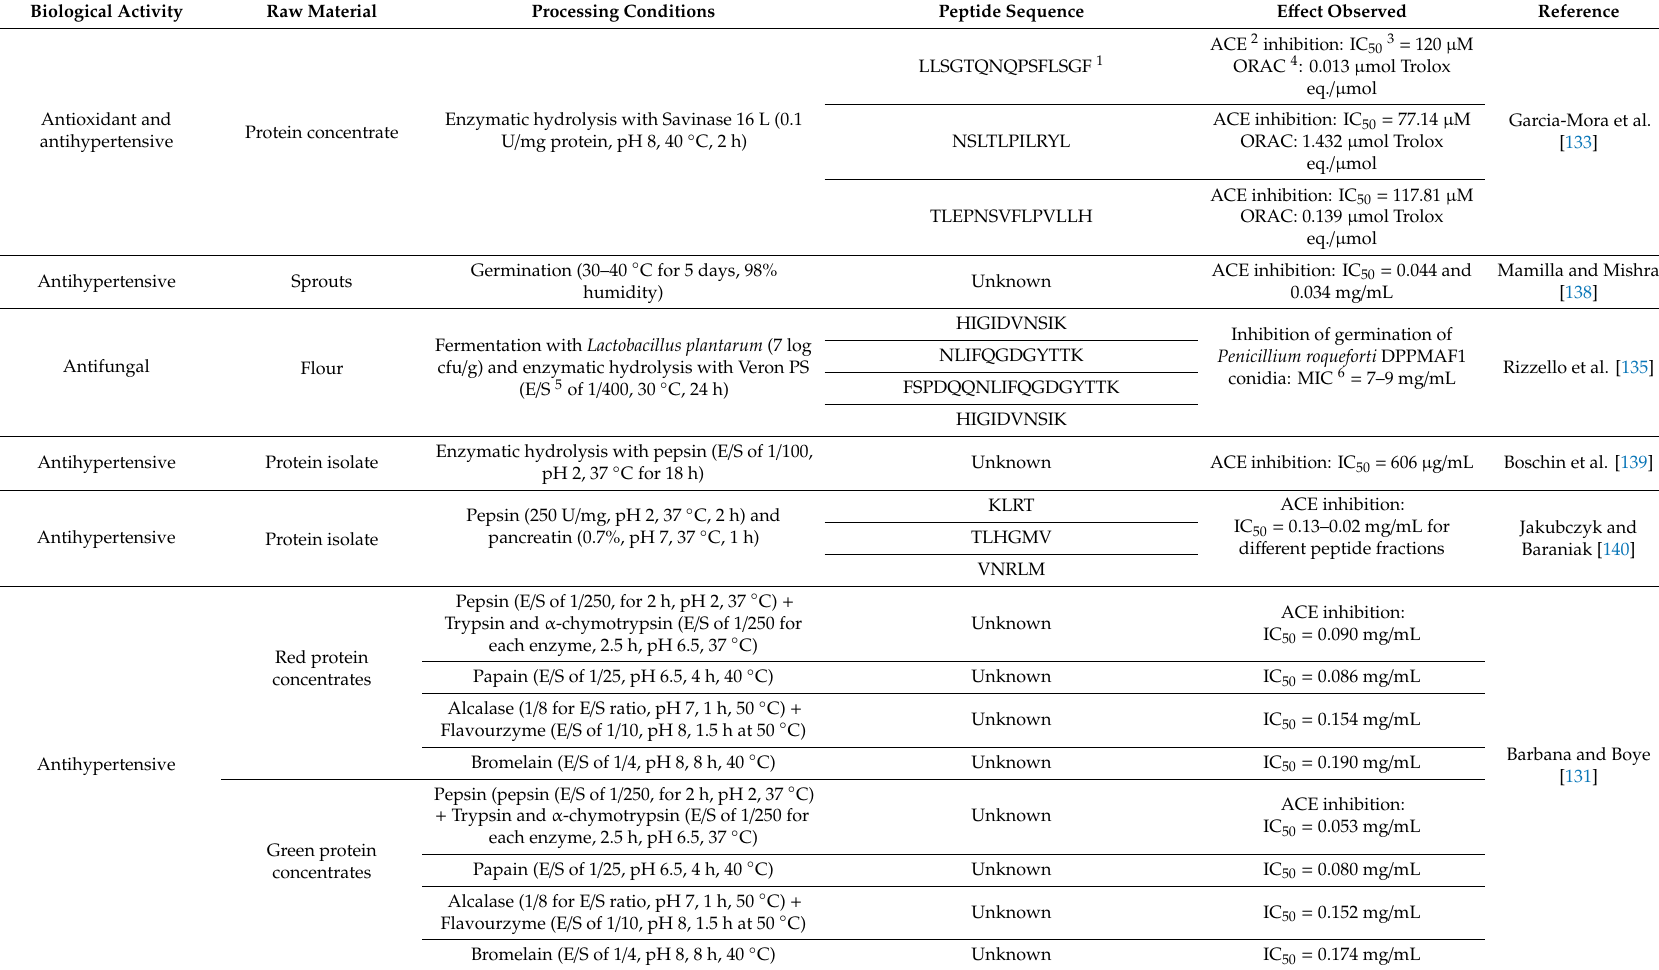
Table 6. In vitro biological activity of cultivated lentil protein hydrolysates and